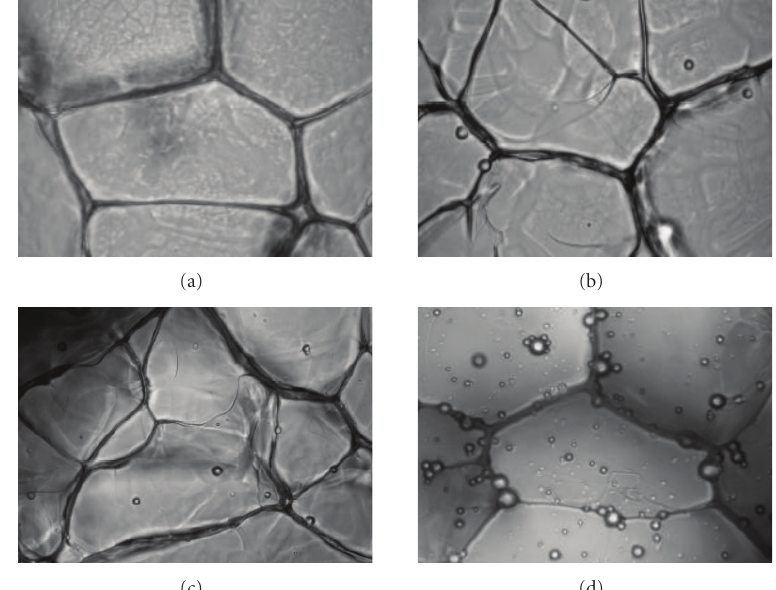
Figure 2: Phase contrast micrograph of PLGA microsphere incorporated gelatin sca ff olds. (a) Pure gelatin sca ff old, (b) 0.1% w/w PLGA microsphere incorporated sca ff old, (c) 1% w/w PLGA microsphere incorporated sca ff old, and (d) 10%w/w PLGA microsphere incorporated sca ff old. Photographs were taken at 40X.